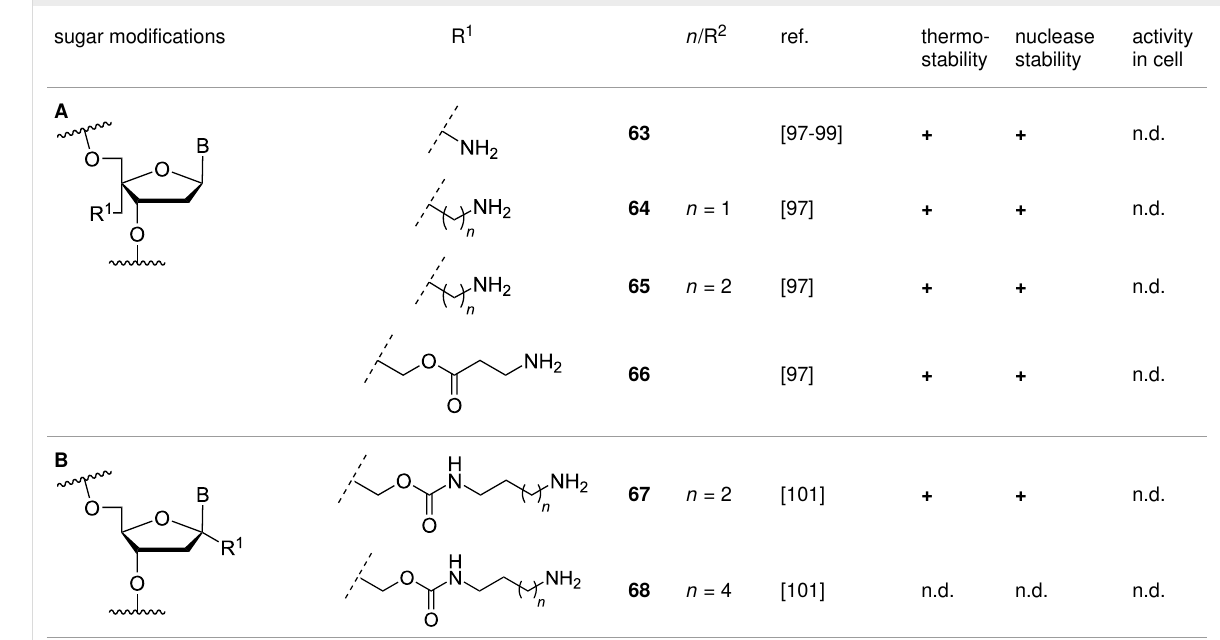
Table 7: Amine-functionalized groups attached to the sugar scaffold. a